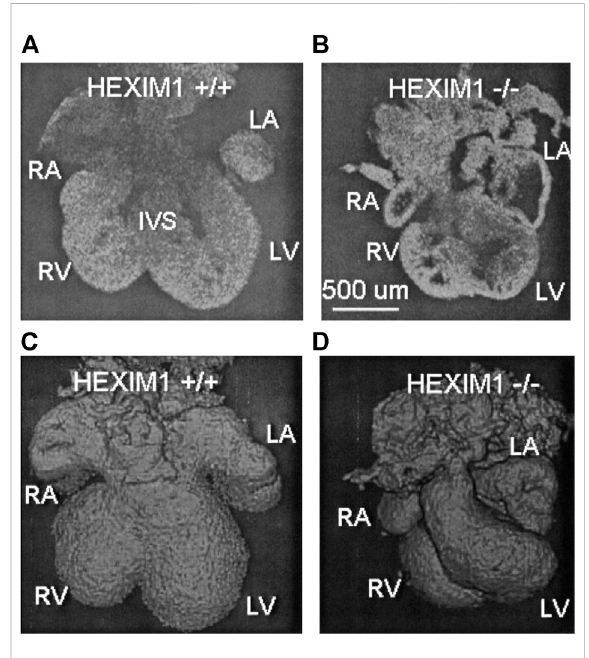
FIGURE 1 OCT structural phenotyping in Hexim1 mutant embryos. Two-dimensional(2-D) OCTimagesofextracted (A) Hexim1 wild- type and (B) Hexim1 mutant hearts reveal enlarged ventricular cavities and thinned myocardium in the mutant heart. Three- dimensional (3-D) volume composite images reconstructed from OCTdataof (C) wild-typeand (D) mutantheartsrevealthatmutant hearts are smaller and developmentally delayed. RA, right atrium; RV, right ventricle; LV, left ventricle; LA, left atrium; and IVS, interventricular septum. Reproduced from (Jenkins et al.,